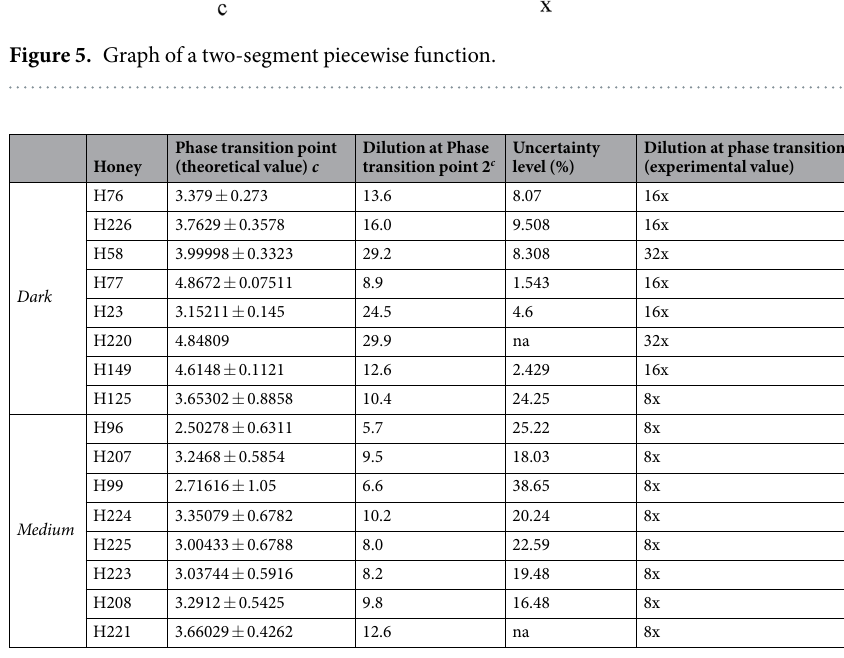
Table 3. A comparison between the theoretical and experimental value of the phase transition